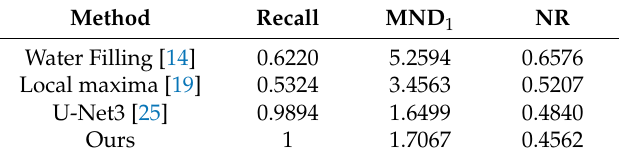
Table 2. Performance of various human detection methods on the TVHeads dataset.